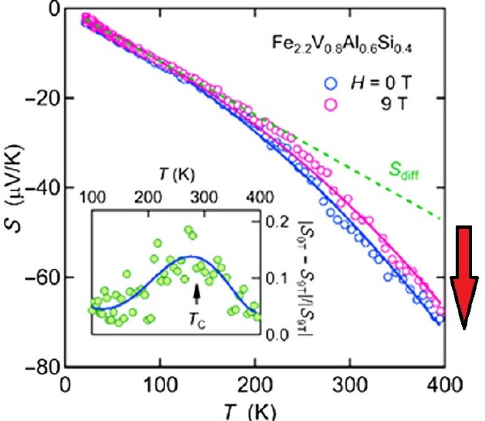
Figure 3. Seebeck coefficient of itinerant ferromagnetic Fe 2.2 V 0.8 Al 0.6 Si 0.4 . The green dashed line is the diffusion value extrapolated from low temperature [34].